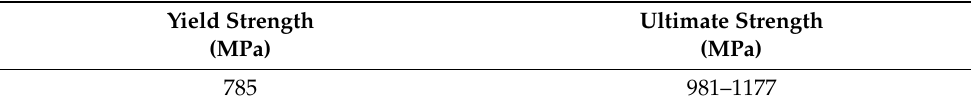
Table 5. Mechanical properties of the material 37Cr4.